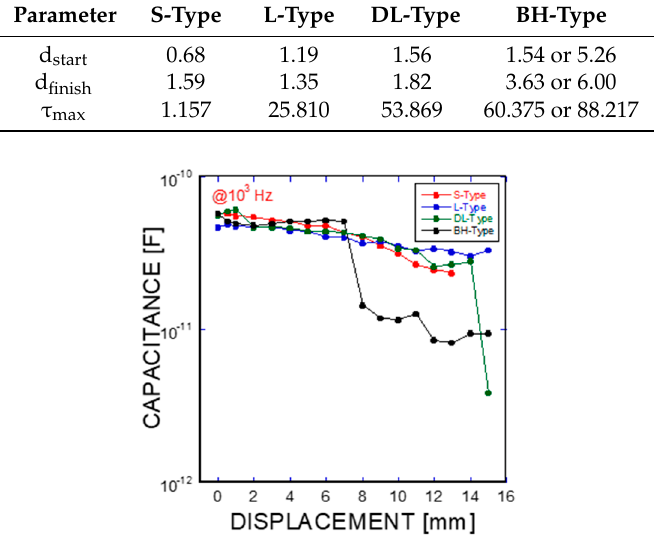
Figure 10. Capacitance change as a function of frequency in terms of the different SMA fiber geometries (S-type, L-type, DL-type, and BH-type Ni/Ti SMA fibers).